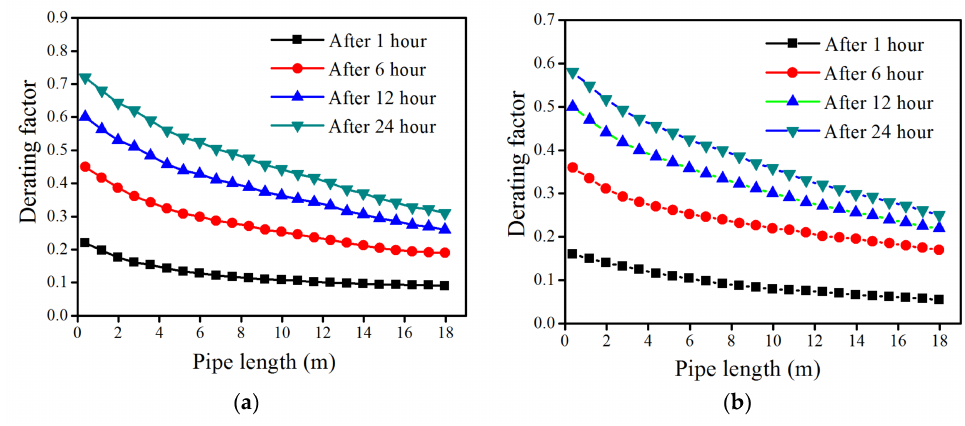
Figure 13. Evolution of derating factor along the length of pipe for different hours of continuous operation under ( a ) the pure heat conduction model and ( b ) the heat and mass transfer